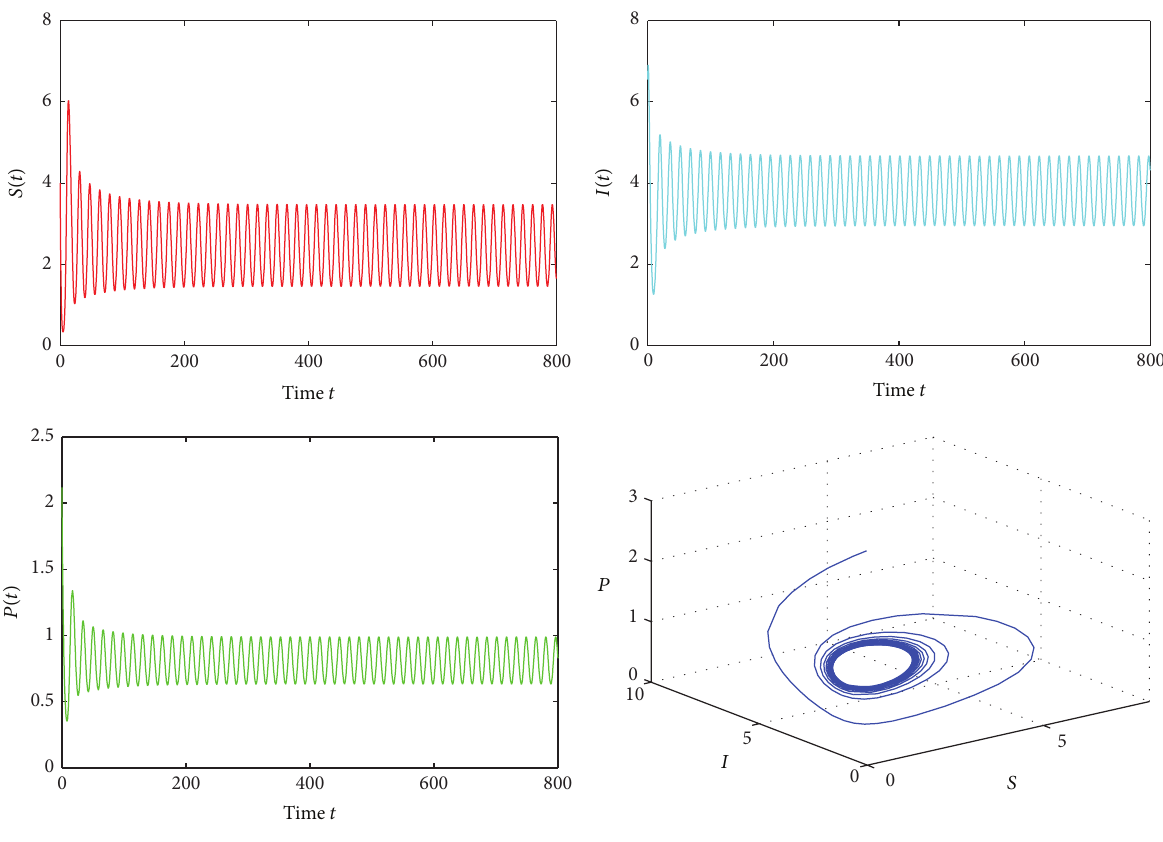
Figure 2: 𝐸 ∗ is unstable when 𝜏 1 = 0.575 > 0.5148 = 𝜏 10